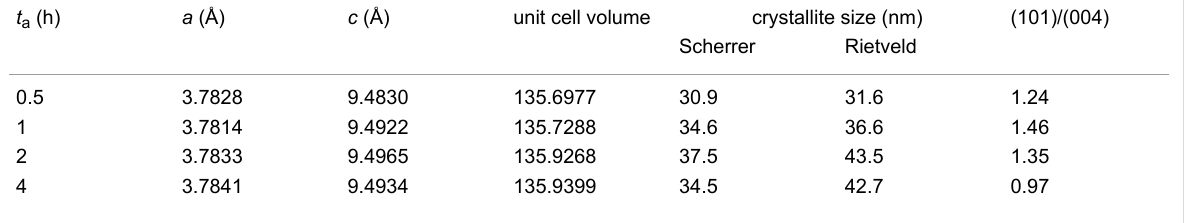
Table 2: Summary of structural parameters estimated from XRD